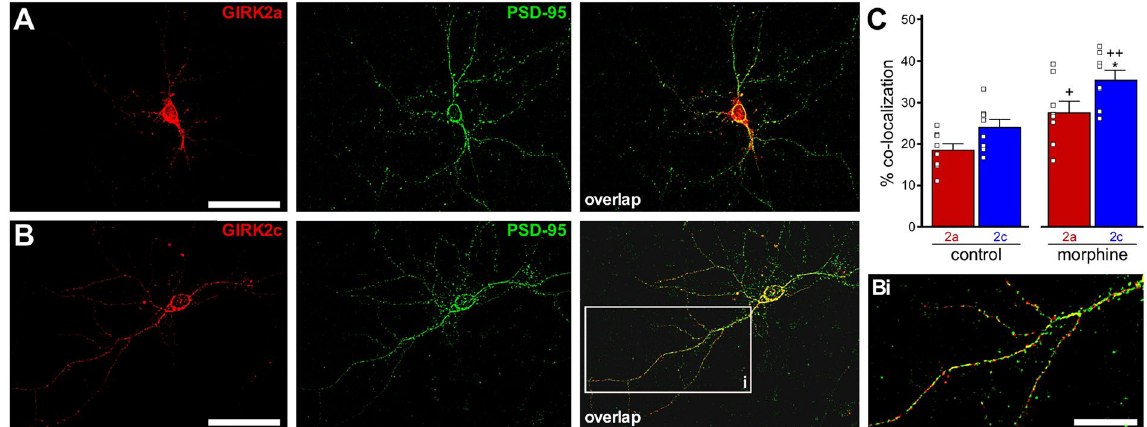
Figure 4. Overlap of GIRK2a and GIRK2c with PSD-95 in pyramidal neurons. ( A,B ) Representative images showing GIRK2 (red) and PSD-95 (green) immunolabeling, and their overlay, in a Girk2 − / − hippocampal pyramidal neuron expressing GIRK2a ( A ) or GIRK2c ( B ). Scale bars: 50 microns. The inset (Bi) highlights the limited overlap between PSD-95 and GIRK2, as demonstrated with GIRK2c. Scale bars: 20 microns. ( C ) Quantification of overlap between PSD-95 and GIRK2a or GIRK2c, under control conditions and following morphine treatment (n = 8 per isoform and treatment condition). Main effects of isoform (F 1,28 = 9.2, P < 0.01) and treatment (F 1,28 = 22.1, P < 0.001) were observed, but there was no interaction between isoform and treatment (F 1,28 = 0.3, P = 0.60). Symbols: * P < 0.05 vs. GIRK2a (within treatment); + , ++ P < 0.05 and 0.01, respectively, vs. control (within